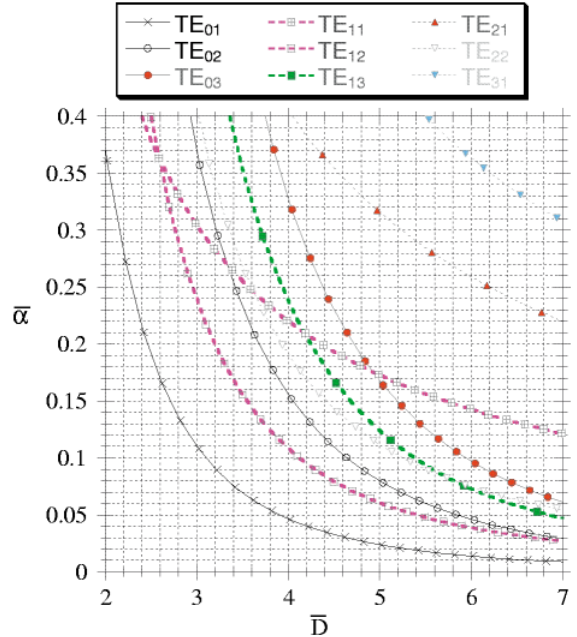
FIG. 1. (Color) Relative attenuation of different TE modes per unit time in circular waveguide versus the normalized diameter of the